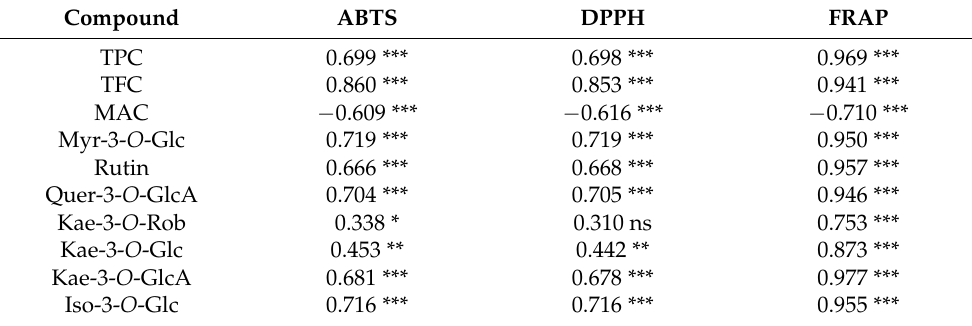
Table 4. Pearson coefficient correlation) between phytochemical profiles and antioxidant activities of the stamen and perianth extracts of 18 N. nucifera populations.